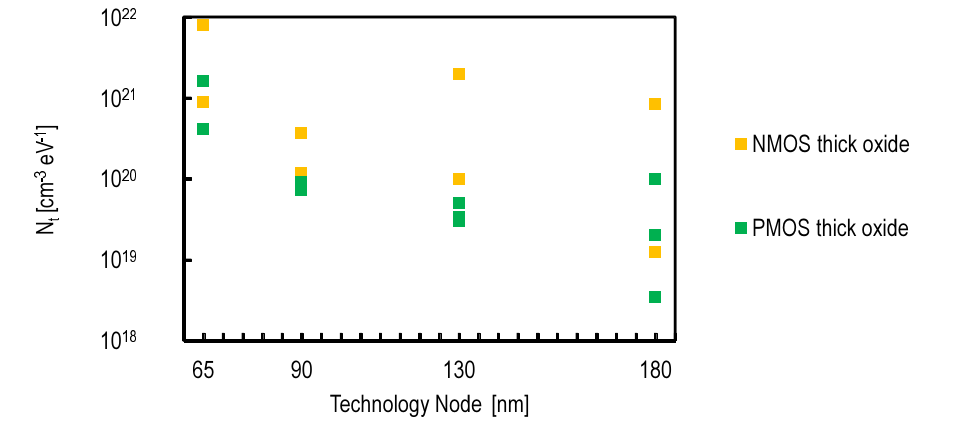
Figure 11. The oxide trap density N t , of PMOS and NMOS thick oxide transistors, as a function of the technology node based on measurement results reported in design kits from different